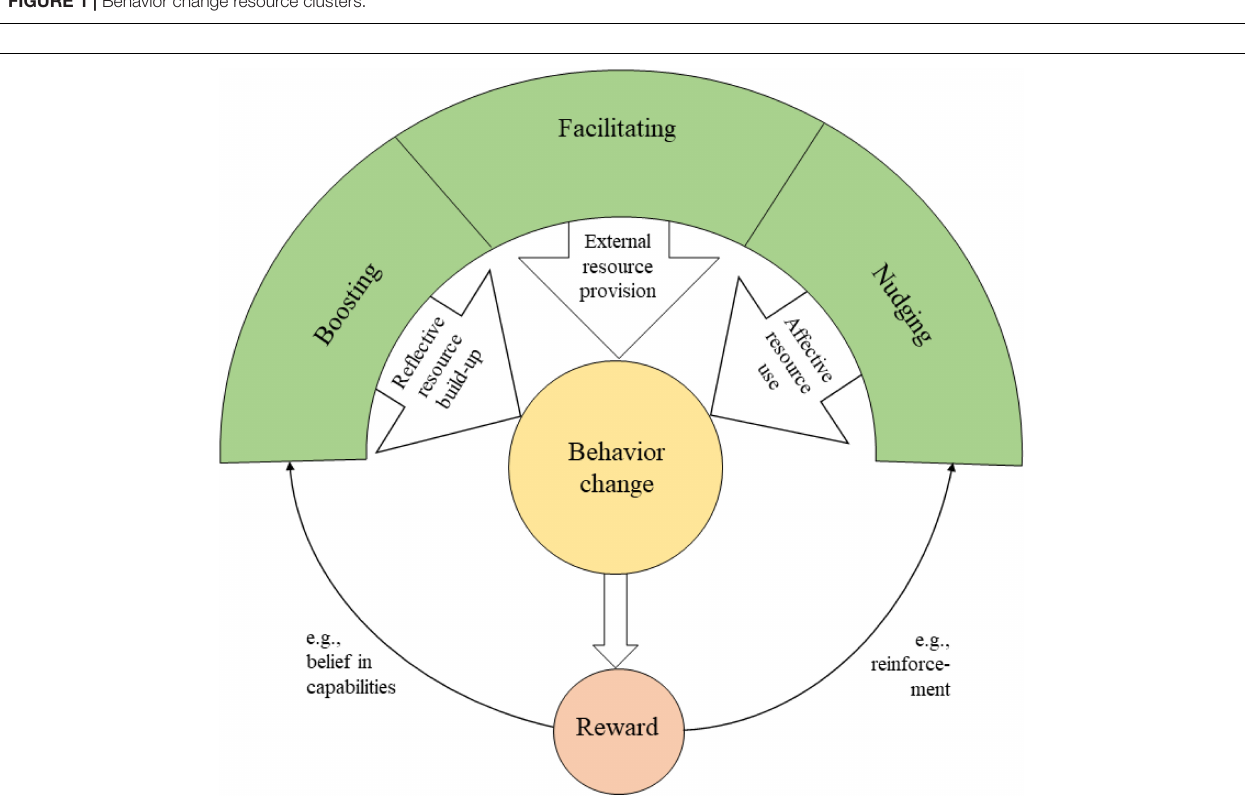
FIGURE 2 | Behavior change resource model. Definitions of Boosting, Facilitating, and Nudging techniques and how the resulting behavior change affects reward